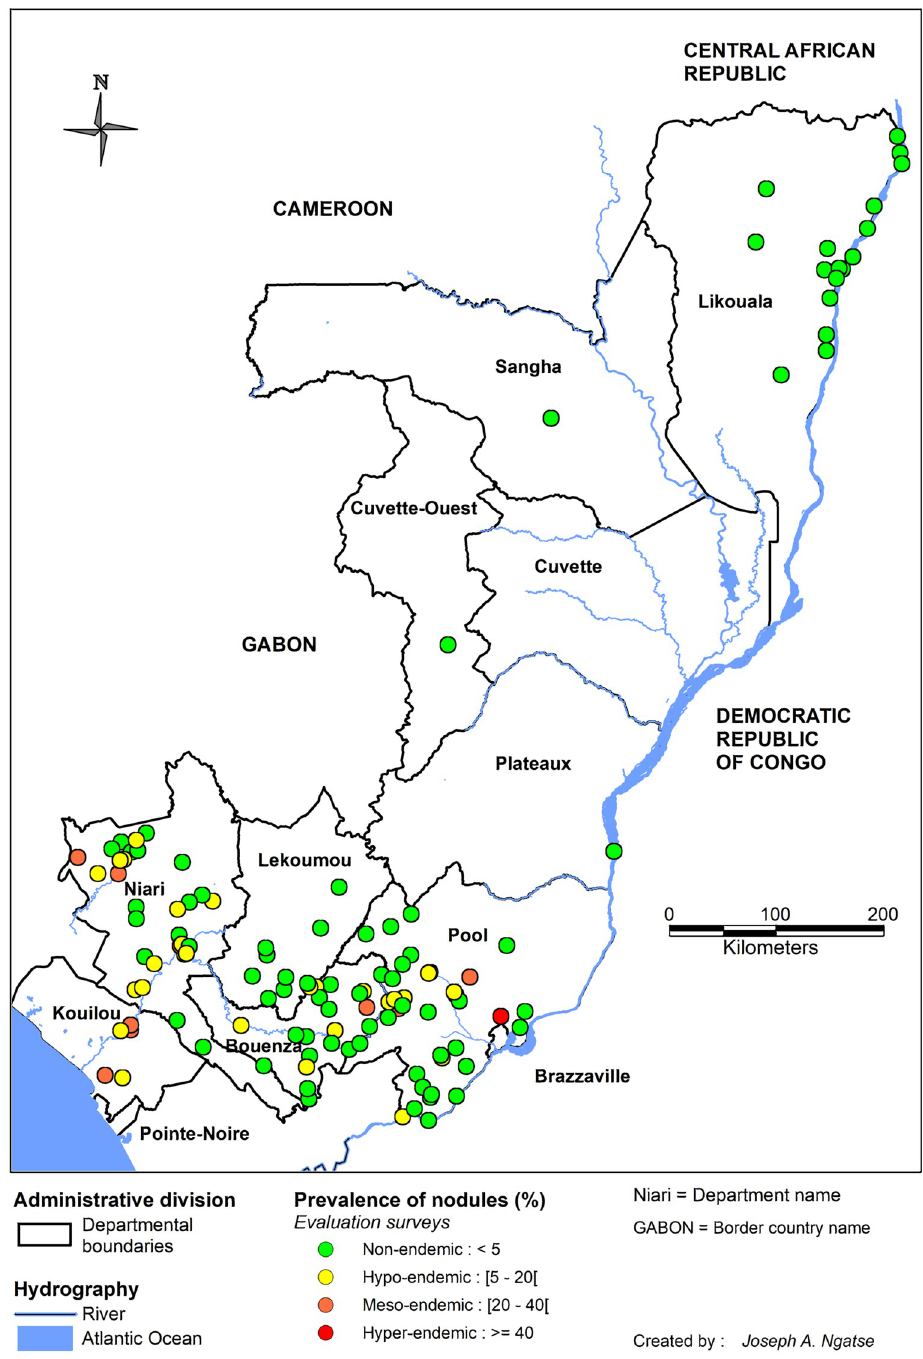
Fig 5. Onchocercal nodule prevalence during the course of CDTI (2011–2015) in the Republic of the Congo. The map was created with MapInfo 8.5 (Geographic Information System, http://www.precisely.com). The base layer used of the map was created by the « Laboratoire Population Environnement De´veloppement » (LPD, UMR 151 AMU-IRD) (https://www.lped.fr/-observatoires-societe-environnement-.html) under the supervision of the Ministry of Health and Welfare of the Republic of